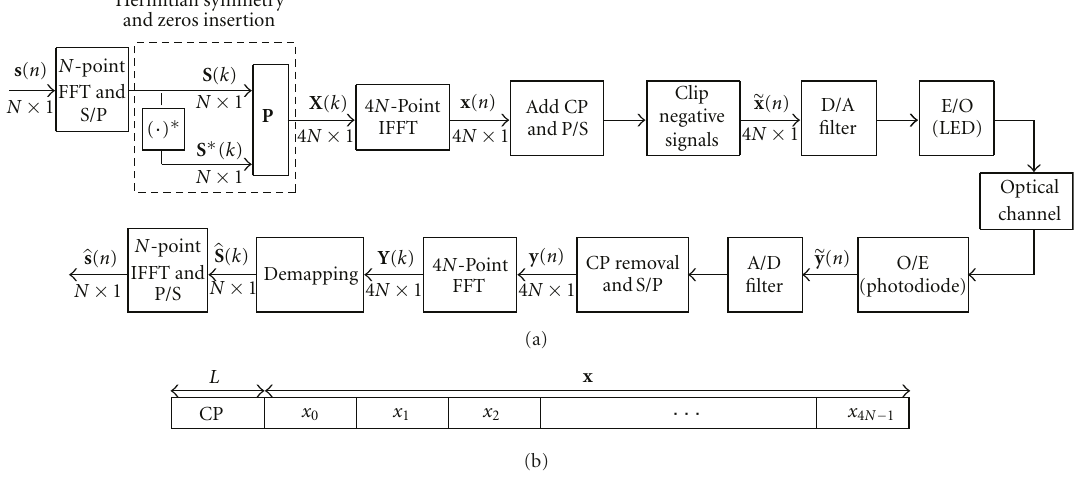
Figure 3: (a) ACO-SCFDE transmitter and receiver configuration. (b) ACO-SCFDE symbol after cyclic extension.